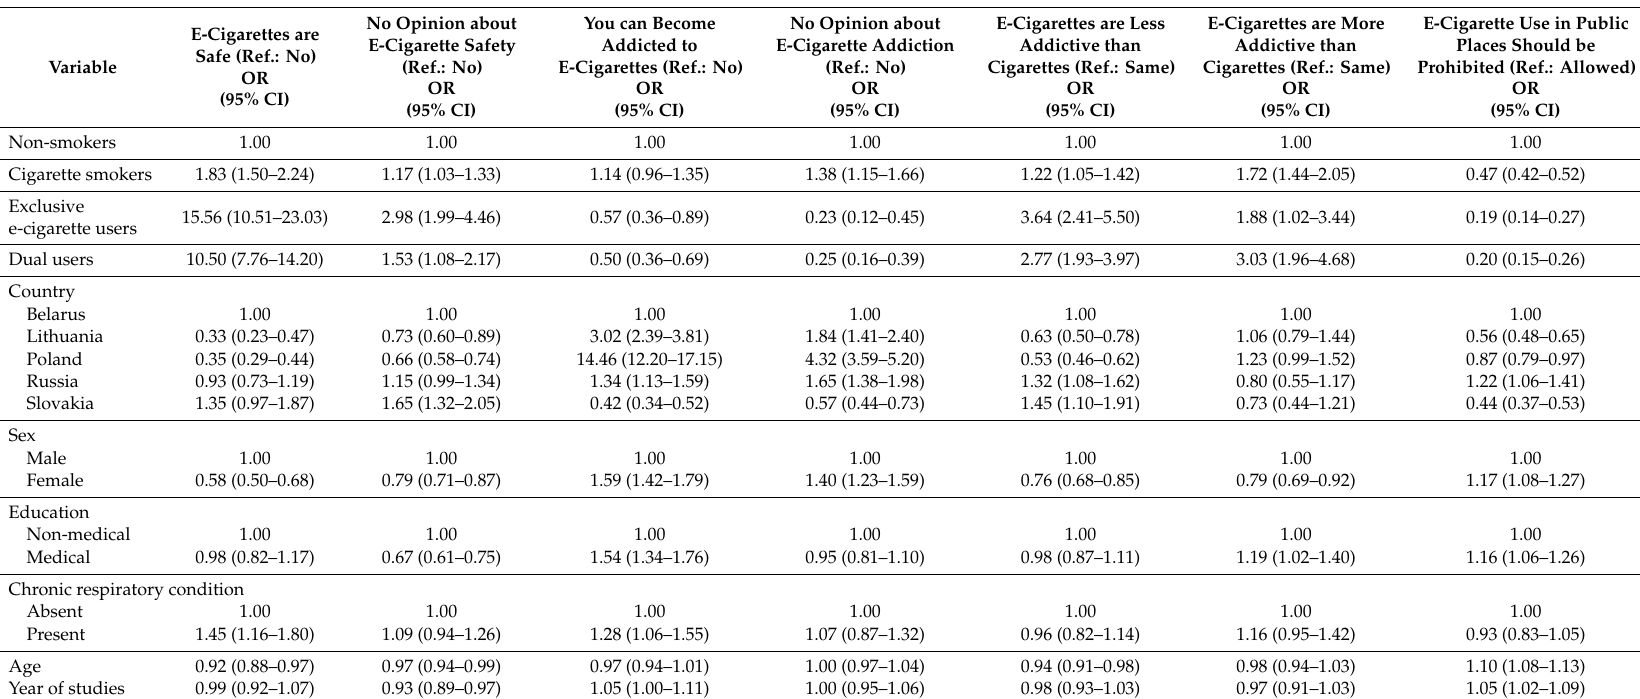
Table 6. Adjusted * associations between smoking status and perceptions of e-cigarette